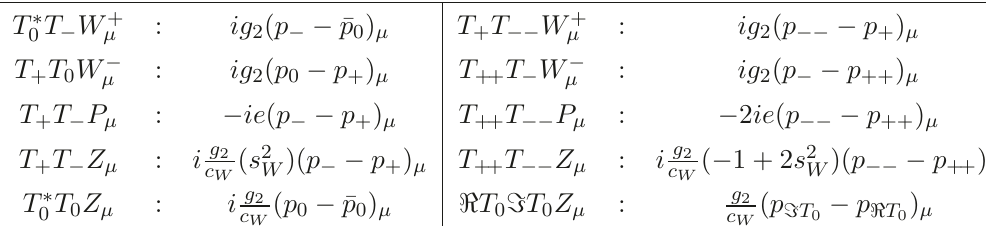
Table 3 . Couplings of gauge bosons to triplet